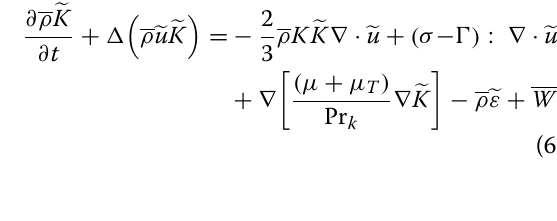
Fig. 3 KH/RT breakup model of fuel